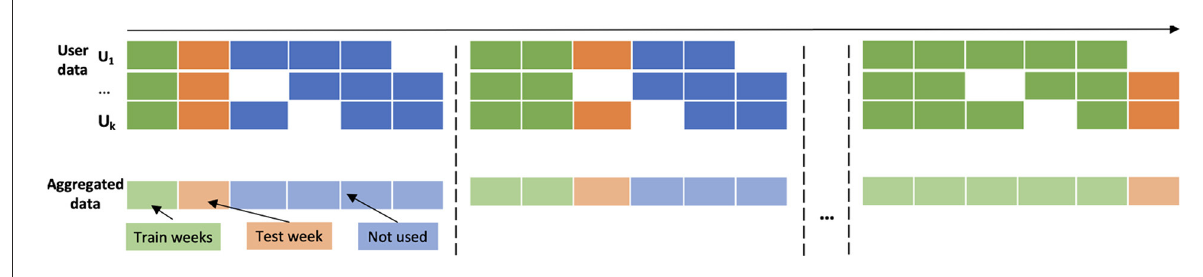
FIGURE4 Evaluation technique used for evaluating week-ahead predictive models.